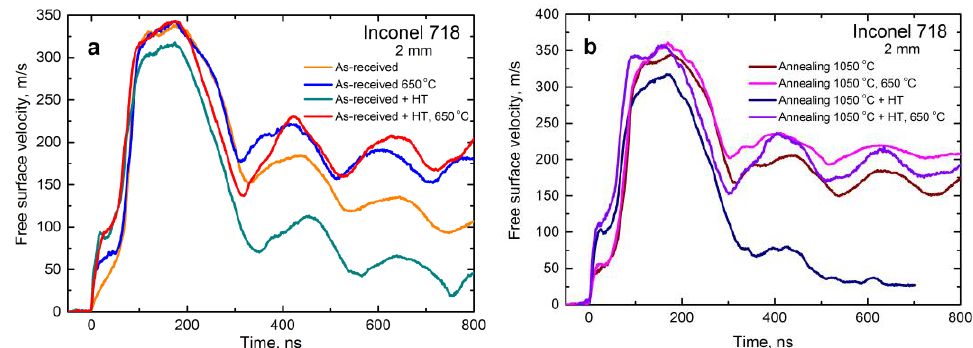
Figure 4. The velocity histories for the samples of superalloy Inconel 718 of 2 mm in thickness after different heat treatment at 20 °C and 650 °C in as-received state ( a ) and after annealing ( b ).